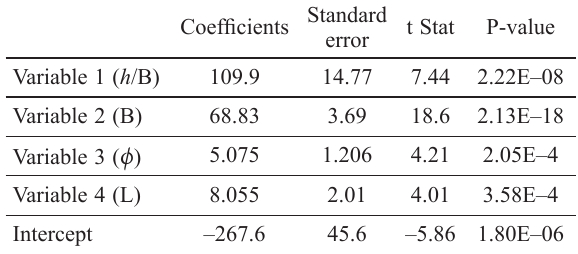
Table 6. Results of multiple regression analysis